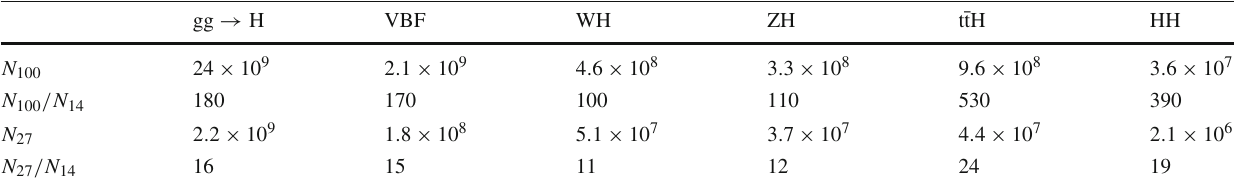
Table 4.3 Higgs production event rates for selected processes at 100 TeV ( N 100 ) and 27 TeV ( N 27 ), and statistical increase with respect to the statistics of the HL-LHC (